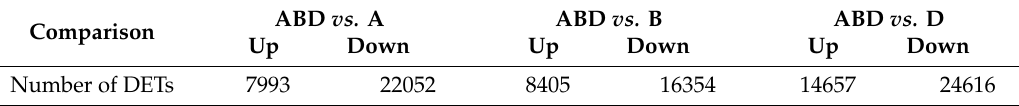
Table 3. Di ff erentially expressed transcripts among bread wheat and its diploid